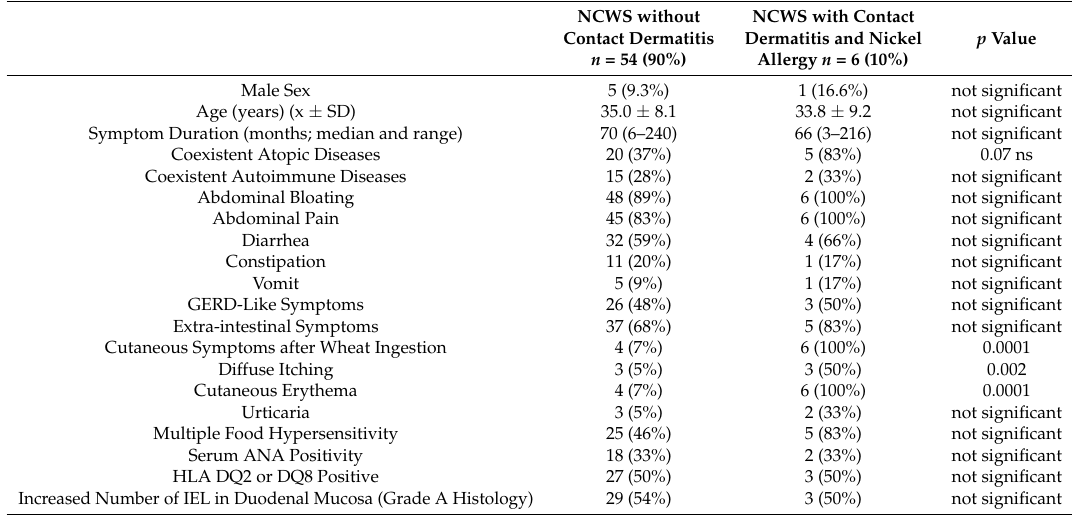
Table 2. Clinical characteristics of the NCWS patients with contact dermatitis due to nickel allergy ( n = 6) compared to NCWS patients who did not suffer from contact dermatitis ( n = 54).